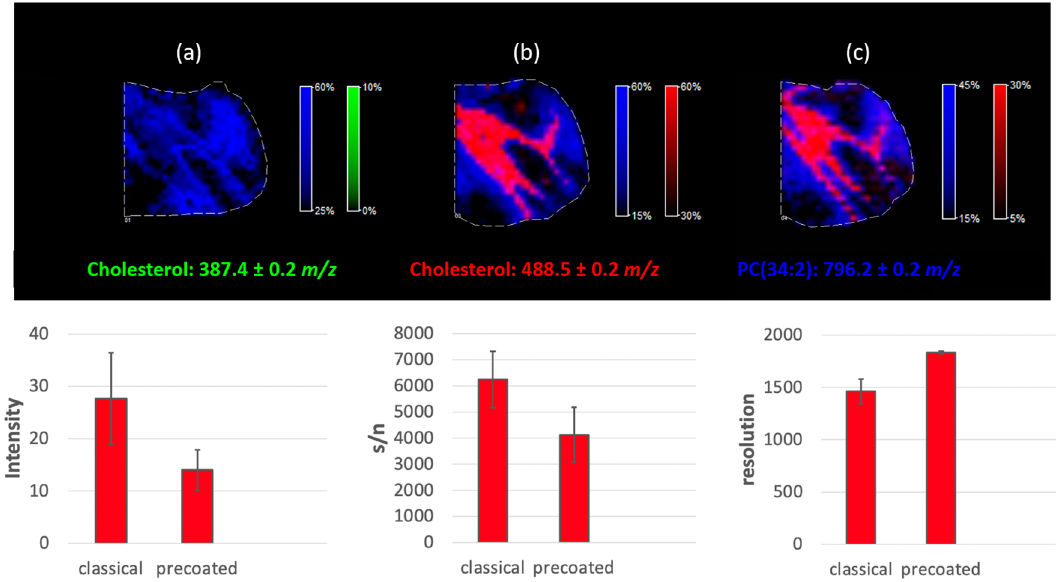
Figure 7. Different approaches to cholesterol analysis in a mouse cerebellum; ( a ) tissue covered only with a CHCA matrix, ( b ) tissue sprayed with a betaine aldehyde solution and covered with a CHCA matrix, ( c ) tissue mounted on the matrix, and betaine aldehyde precoated ITO glasses covered with CHCA matrix (please note the color scale bars and % of inten- sities).